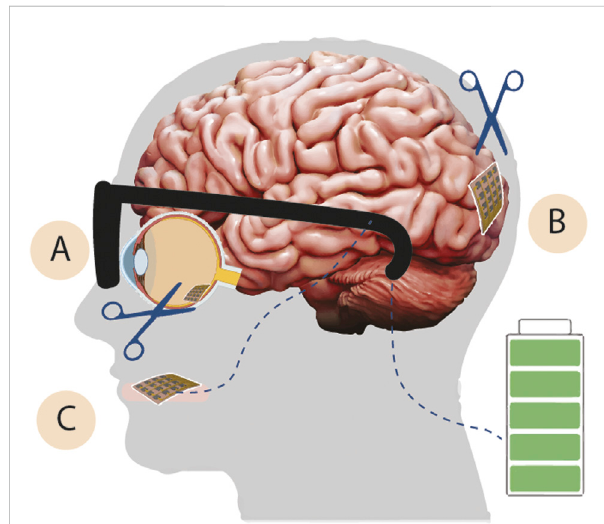
FIGURE 5 Arti fi cial visual prosthetic designs. Goggles with an integrated camera and transmitter ( black ) connected to a battery and visual processing unit ( green, right side ) are required for existing arti fi cial visual prosthetics. The goggles transmit stimulation signals to (A) retinal prosthetic devices, surgical implantation ( scissors ) of an electrode array with a receiving coil facilitates stimulation of retinal ganglion cells (B) cortical prosthetic devices, surgical implantation of an electrodearray intheprimary visualcortex(V1) with areceiving coil facilitates stimulation of these cortical neurons (C) non-implanted visual prosthetics, placed on the user ’ s tongue contains integrated receiver for delivering electrical stimulation to the tongue ( pink